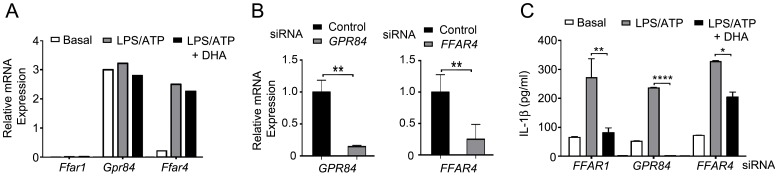
DHA-mediated suppression of inflammasome activity depends upon FFAR4.(A) Quantitative RT-PCR to detect Ffar1, Gpr84, and Ffar4 mRNA expression in BMDMs. Cells were LPS primed and ATP treated. DHA (100 µM) added during priming step, or not. Data is relative to Gapdh expression x 105. Experiment performed 2 times with similar results. (B) Quantitative RT-PCR to detect GPR84 or FFAR4 mRNA in LPS primed THP-1 cells expressing siRNAs targeting FFAR4 or GPR84, respectively. The results were normalized to β-actin expression and shown as relative to control. (C) IL-1β ELISA to assess inflammasome activity in FFAR1, GPR84, or FFAR4 knock-down cells. LPS primed THP-1 cells expressing siRNAs targeting FFAR1, GPR84, or FFAR4 were stimulated with ATP. DHA added during the priming step. Similar results from 3 experiments. *P<0.05, **P<0.001, ****P<0.0001.